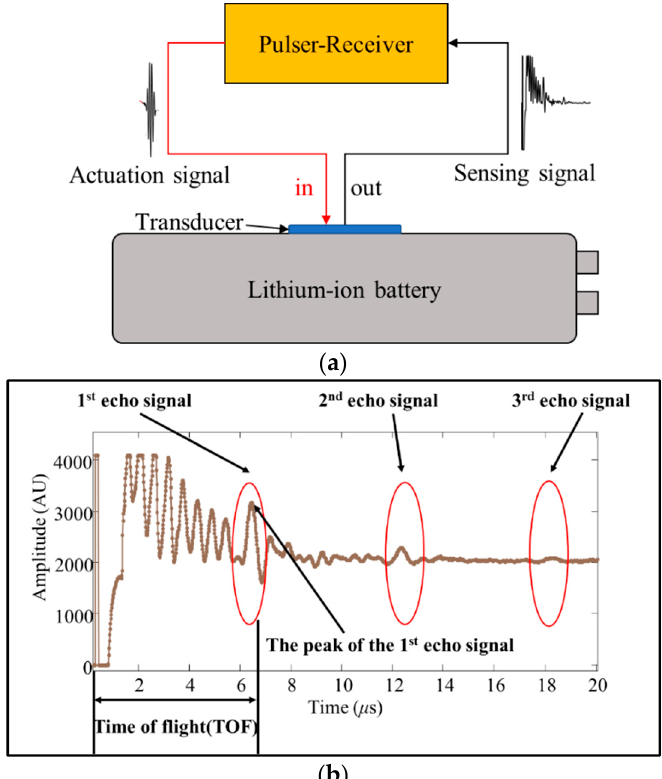
Figure 1. ( a ) Schematic for battery ultrasonic sensing and ( b ) representative ultrasonic response signal of a lithium-ion battery.